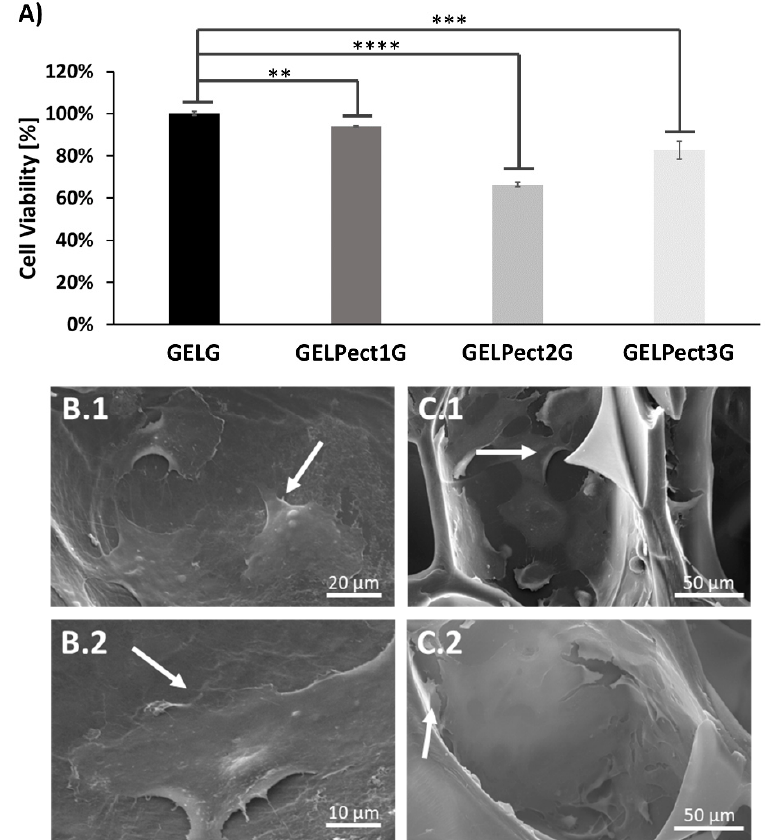
Figure 4. Cell viability at 48 h of MG-63 cells seeded on GELG and GELPectG sponges (Student’s t -test significance levels: ** = p < 0.005, *** = p < 0.0005, **** = p < 0.0001, comparing the metabolic activity of cells on GELG (control) and on other GELPectG sponges) ( A ). Representative SEM images of adherent MG-63 cells on GELPect1G ( B.1 , B.2 ), and GELPect3G ( C.1 , C.2 ) sponges at 48 h. (Scale bars: B.1 = 20 µm, B.2 = 10 µm, C.1,C.2 = 50 µm).